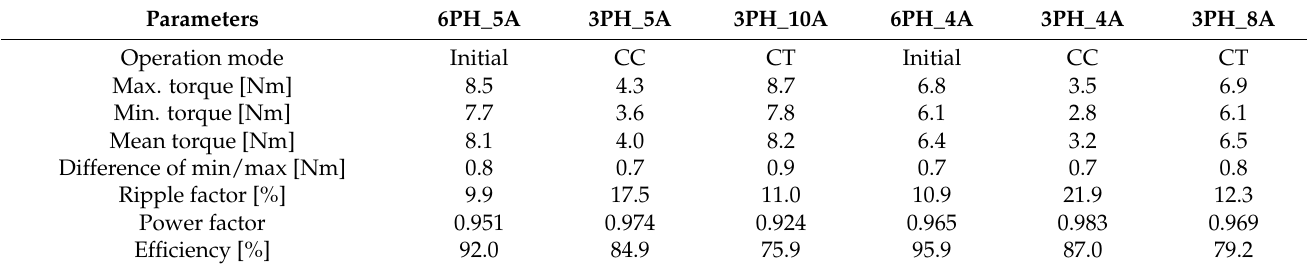
Table 7. Performance of each case of operation modes for six- and three-phase.